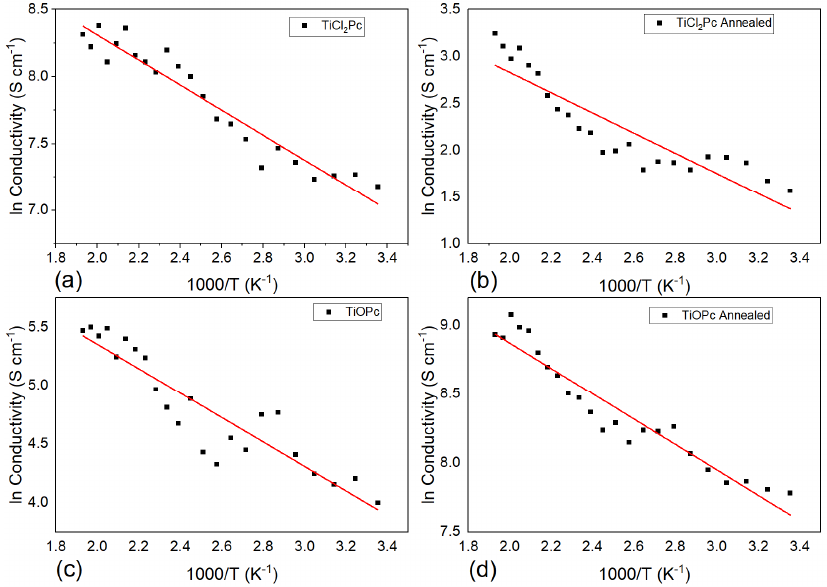
Figure 9. Arrhenius plot of TiCl 2 Pc and TiOPc before ( a , c ) and after annealing ( b , d ),